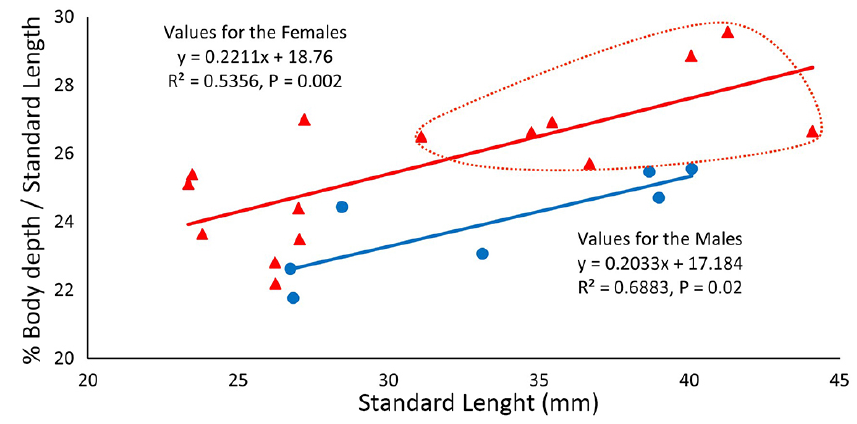
FIGURE 5 | The proportion of body depth at dorsal-fin origin (% SL) versus the standard length (mm) in females (red triangles) and males (blue dots) in Characidium onca . Symbols indicating the mature females are highlighted in the dashed area.